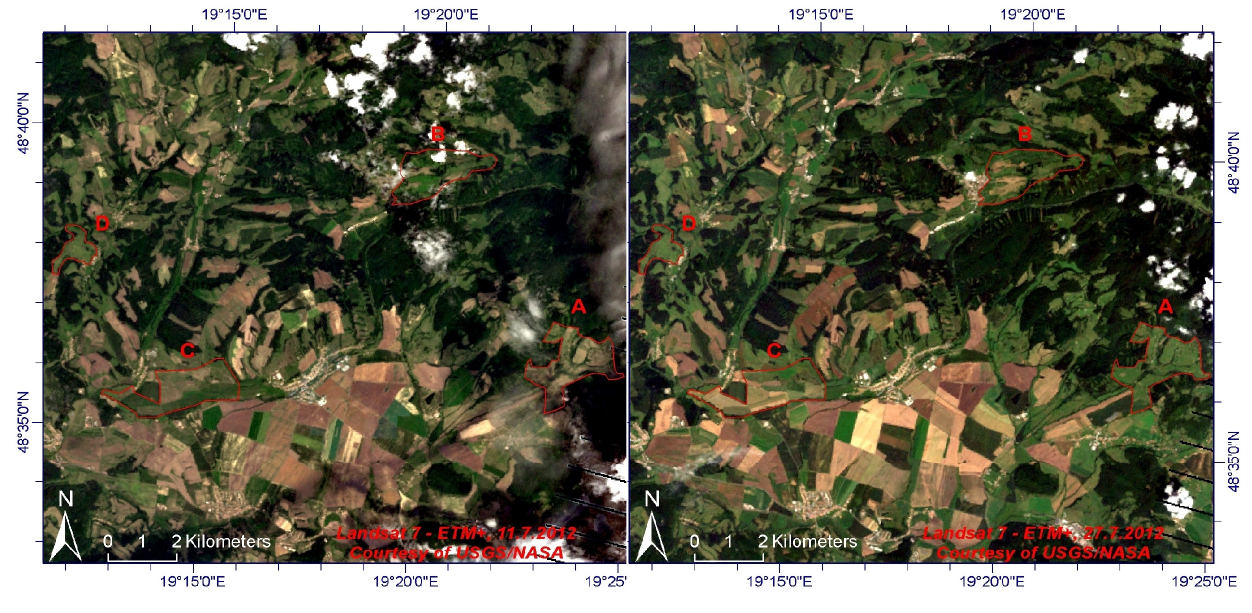
Figure 2. Preliminary detection of cutting on selected sites. A. Cutting before 11.7.2012. B. and C. cutting between 11.7, and 27.7. 2012. D. No cutting in these periods.